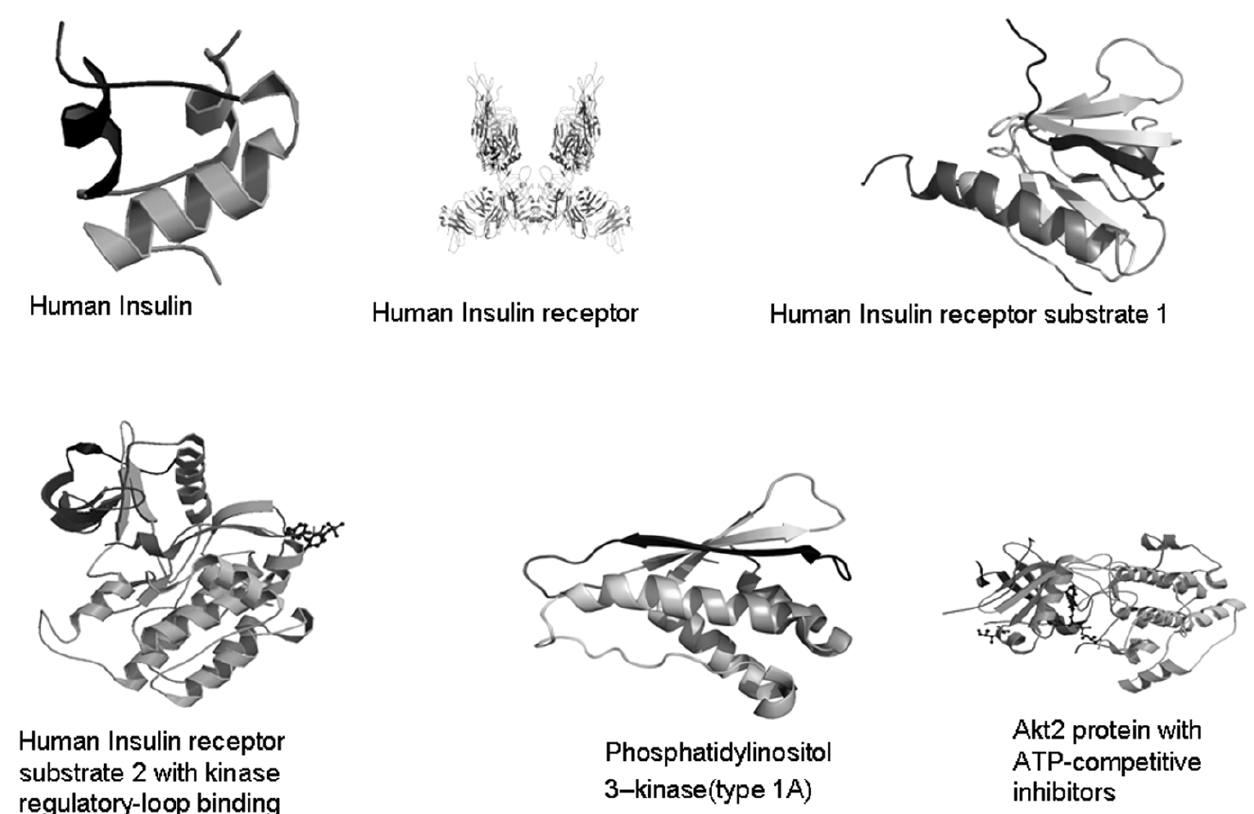
Figure 5. Ribbon like structure of the main functional proteins associated with pathway. Collected from Protein Data Bank.